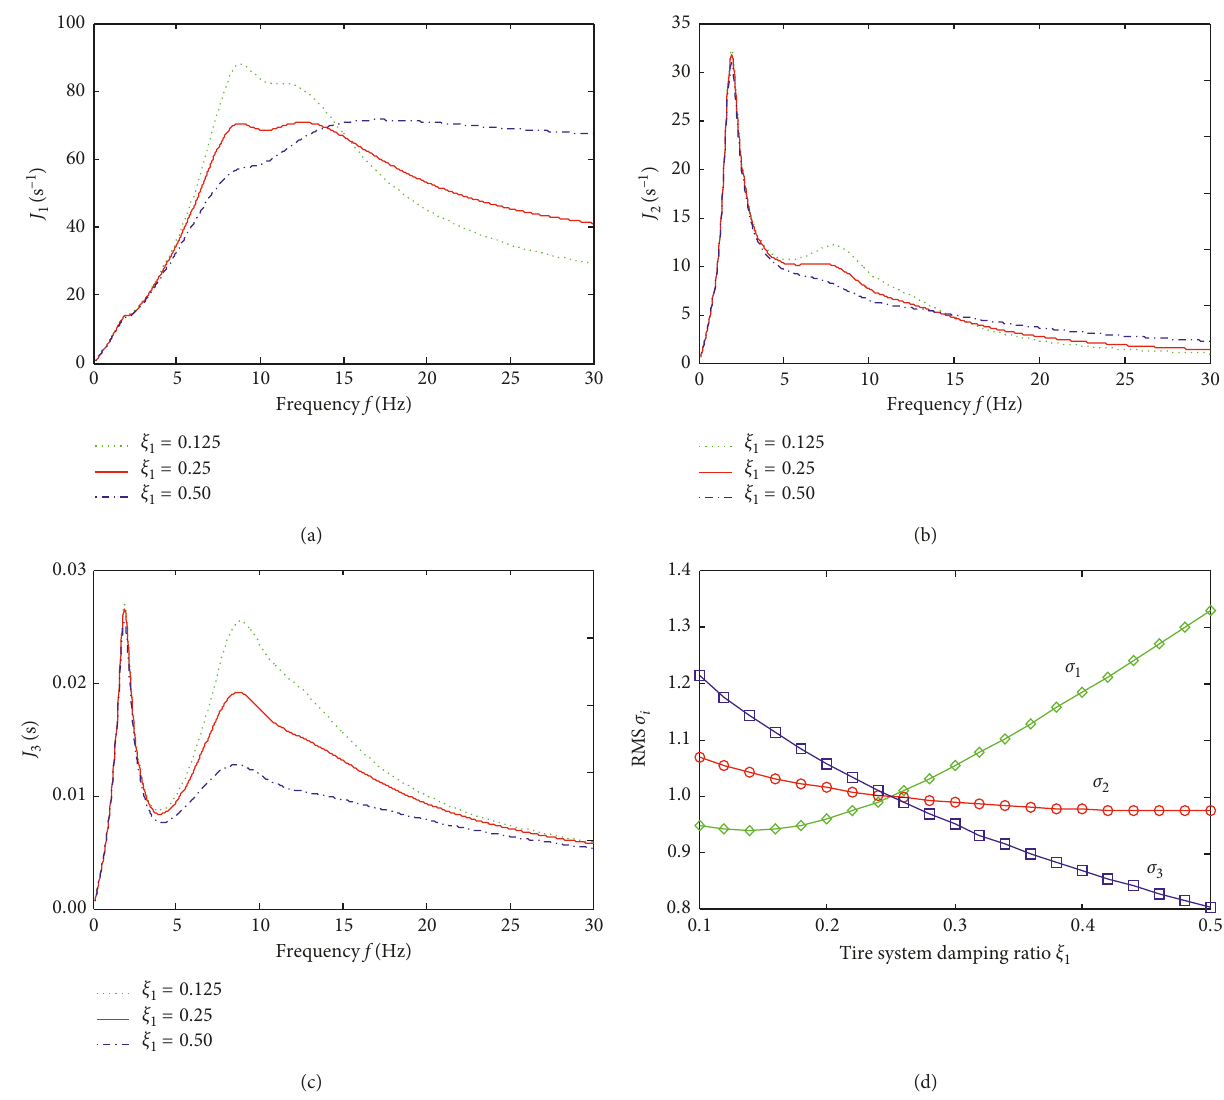
Figure 7: Influences of ξ on € z , € z , and f : (a) the amplitude frequency characteristics J 1 1 2 d at different values of ξ ; (c) the amplitude frequency characteristics J frequency characteristics J 2 1 σ , and σ versus ξ 2 3 1